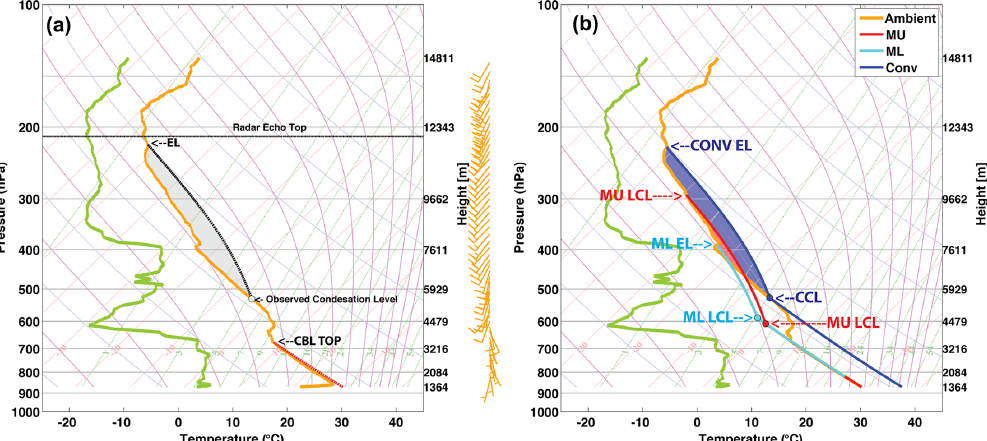
Figure 9. Thermodynamic analysis of the ambient environment and plume parcels. (a) Observed sounding from 2 August 2014, 21:00PDT showing the adjusted boundary layer profile (dashed red line), the lidar-derived condensation level (gray circle), the moist-adiabatic ascent from the condensation level, equilibrium level, and the radar-derived echo tops. (b) Analysis of lifted parcels, showing the most unsta- ble (MU), mixed-layer (ML), and convective (CONV) parcel trajectories. The condensation and equilibrium levels for each parcel are shown, and their CAPE is